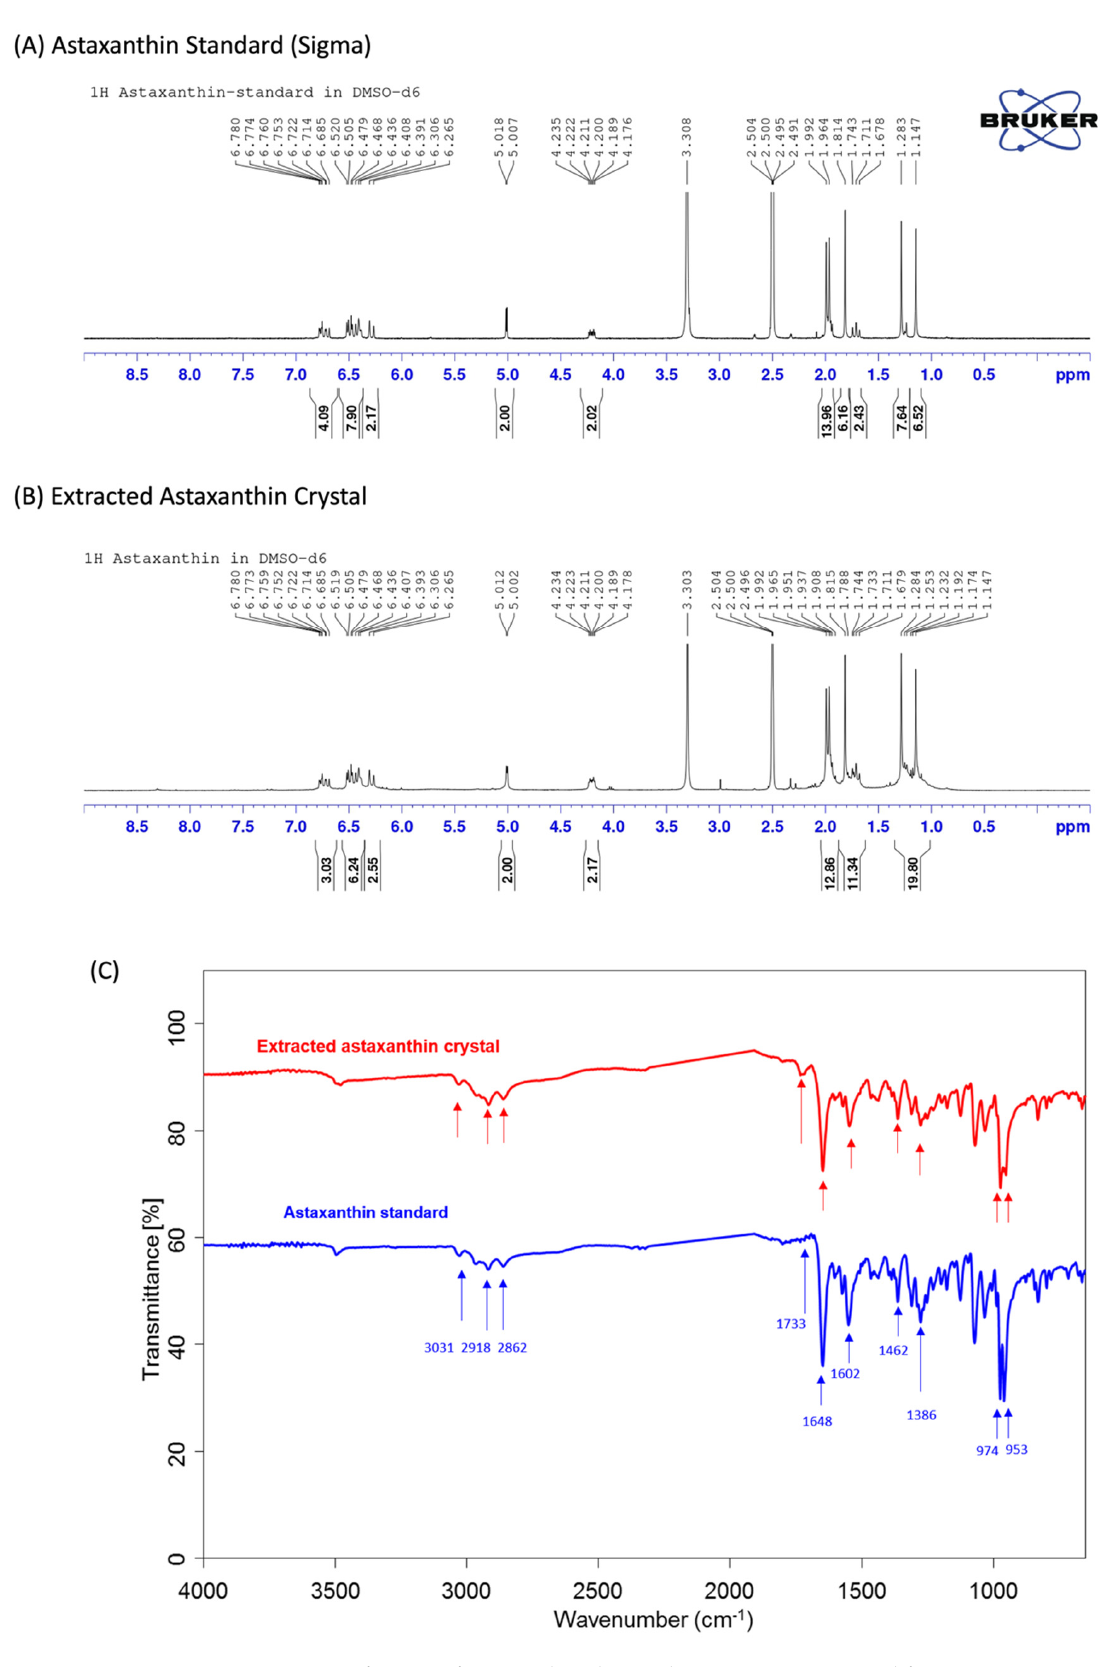
Figure 2. Verification of astaxanthin chemical composition extracted from K. marxianus 6 − 13 − a6 by NMR ( A , B ) and FTIR ( C ).